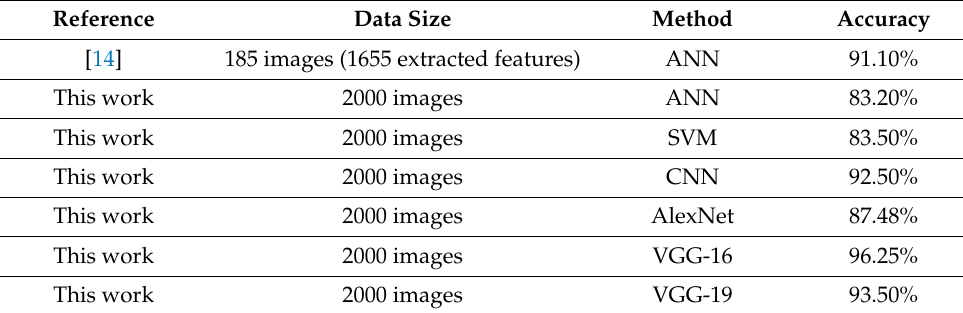
Table 8. Results from other references for Nosema